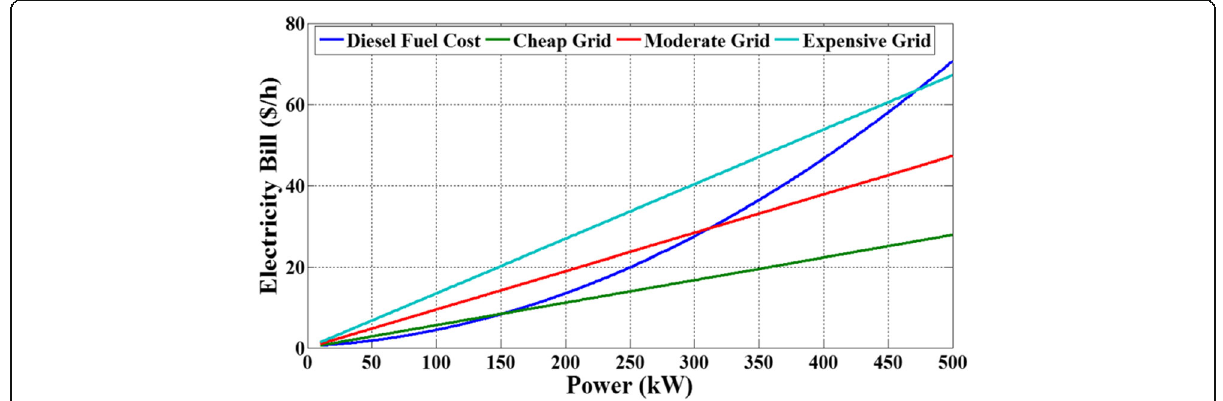
Fig. 13 Comparison of diesel fuel cost vs. time-varying grid-price